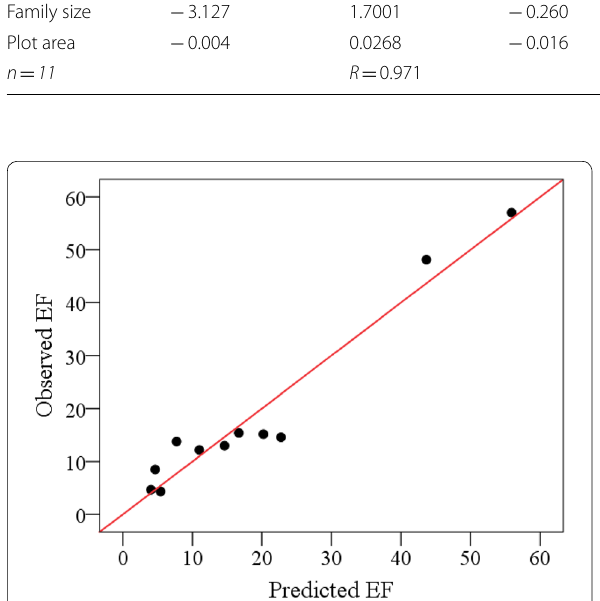
Fig. 5 Scatter plot of observed EF versus predicted EF overlaid with best fit linear regression